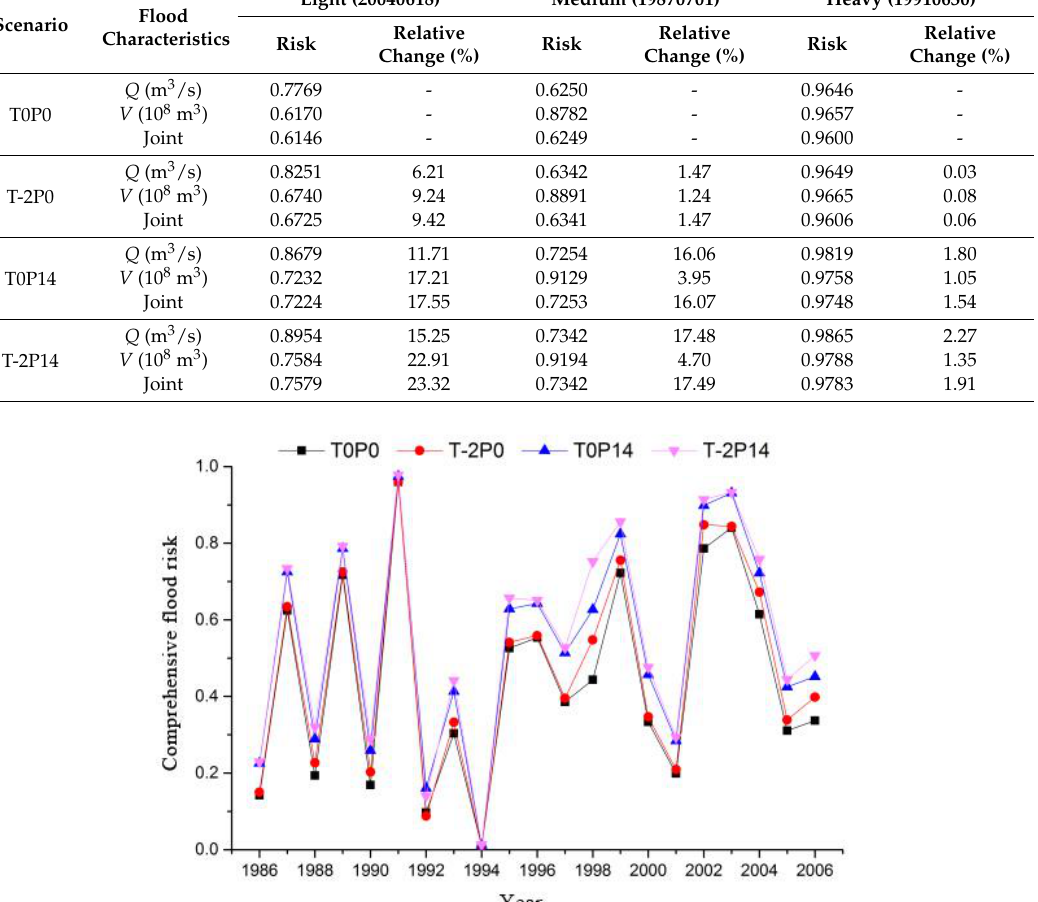
Figure 8. The comprehensive flood risk comparisons under the four different climate scenarios.